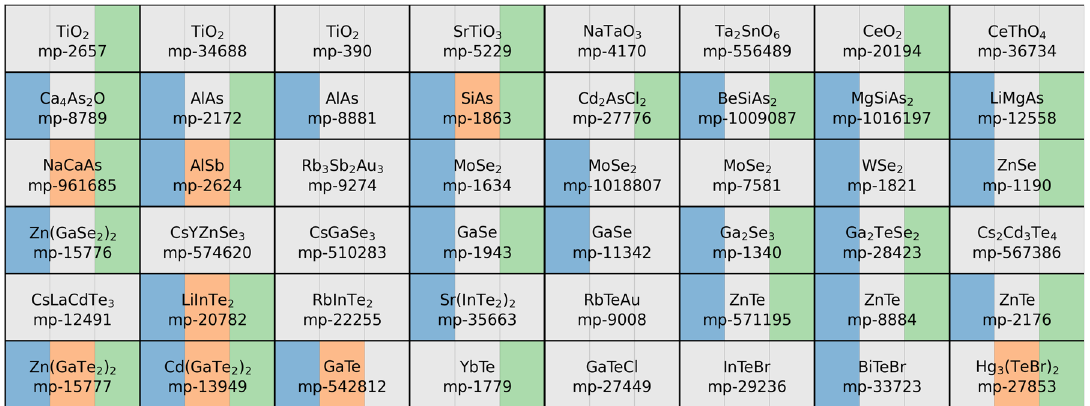
Fig. 5 The fi gure shows a color-coded map that indicates which of the screening criteria are satis fi ed by the 48 materials. The materials that satisfy the EBE criteria 1 are shaded in blue. The materials that satisfy both criteria 2 and 3 of meeting the cutoff of α avg visible-light region (1.7 – 3.5 eV) are shaded in orange. The materials that satisfy criteria 2 and 3 in the UV region (3.5 – 4.2 eV) are shaded in